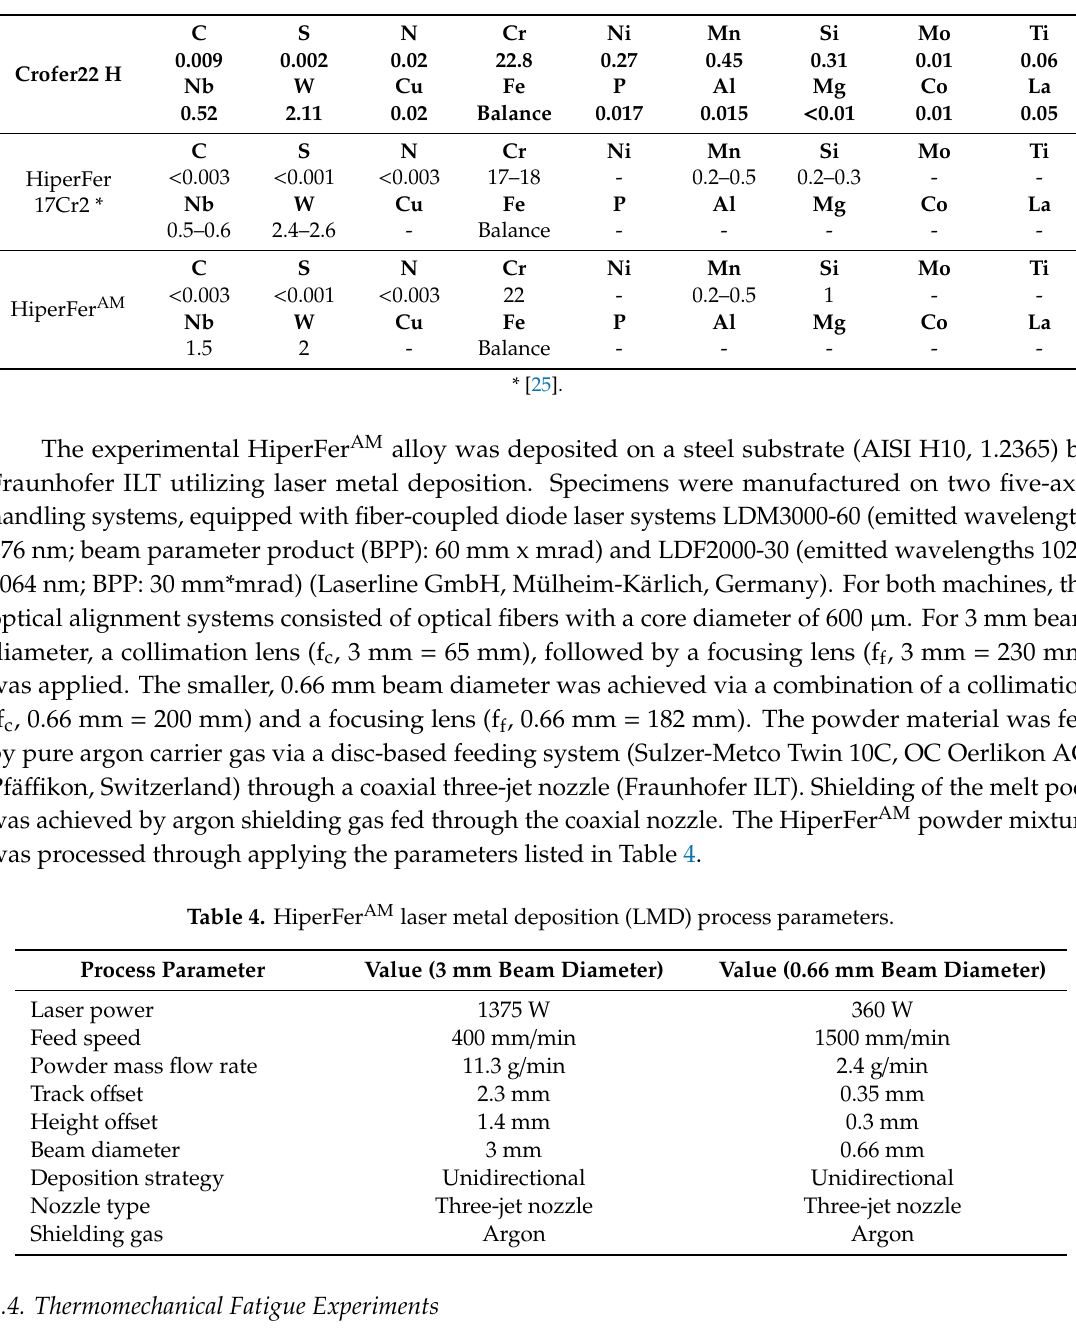
Table 3. Chemical compositions of the ferritic steels (wt.-%).